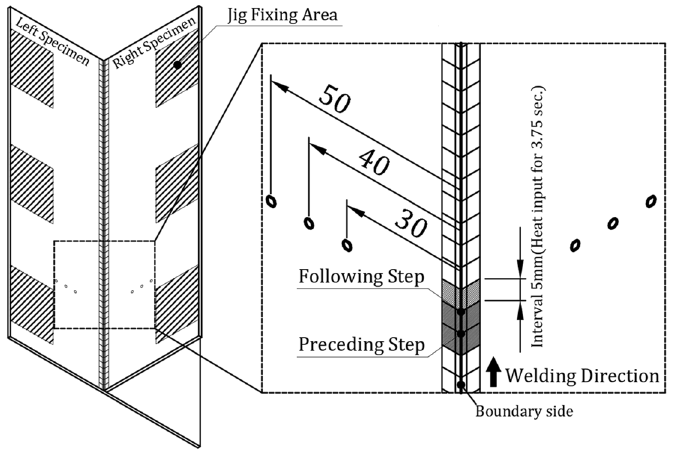
Figure 10. Pre-process of heat transfer analysis for the specimen unit.